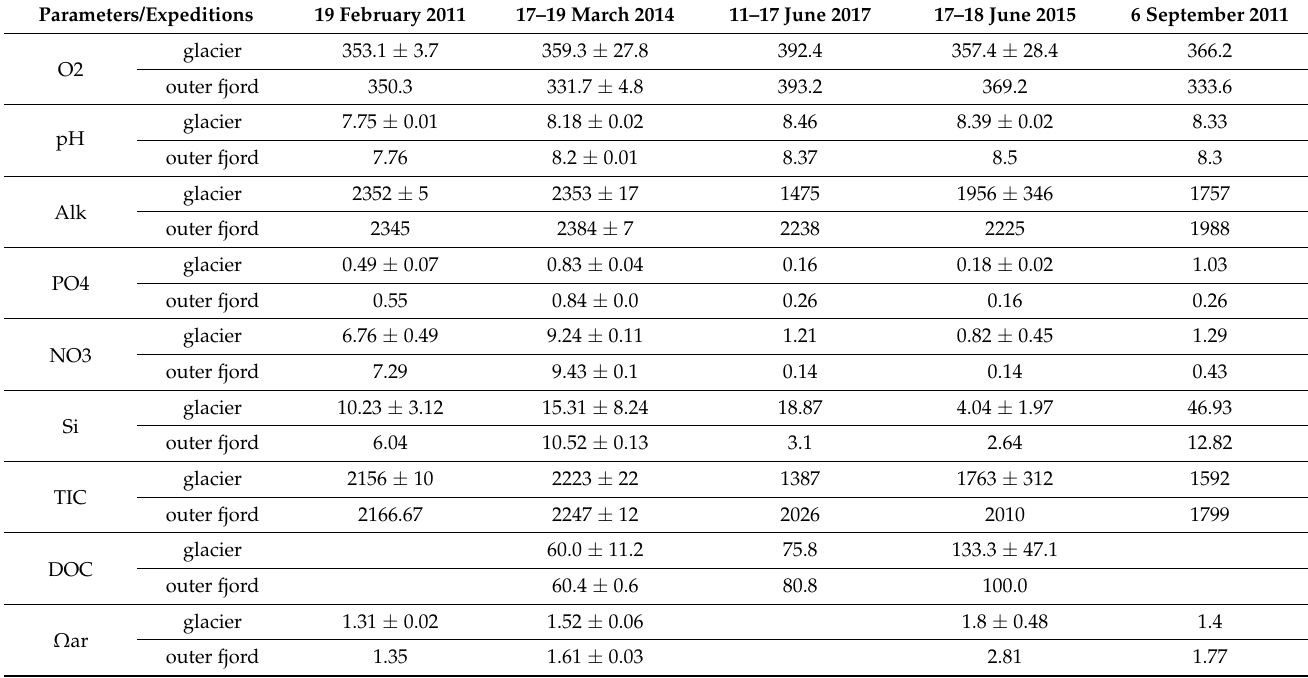
Table A6. Seasonal and interannual changes of nutrients in the surface layer, not affected by the river plume in the near-glacier region and the outer fjord.